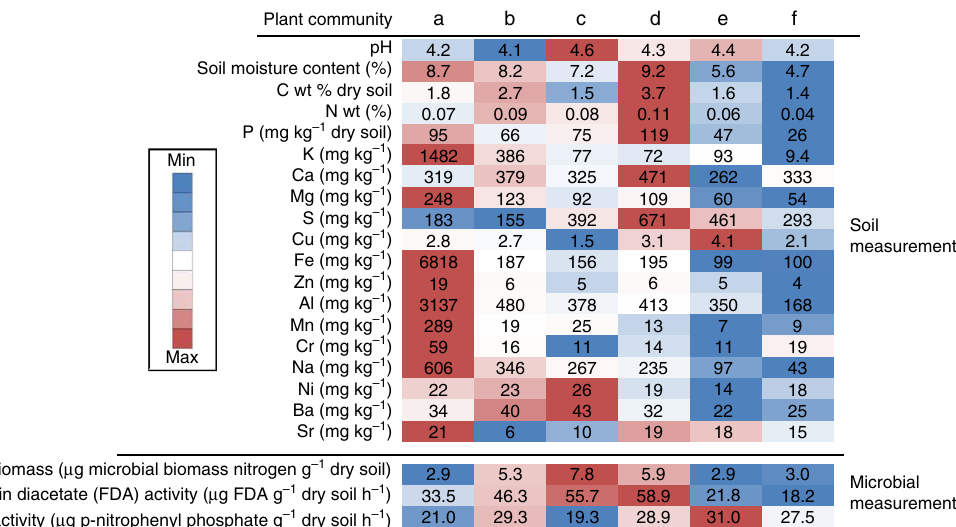
Fig. 3 Soil chemical characteristics, microbial biomass, total enzyme, and phosphatase activity measured in bulk soils. Values shown are the average of fi ve soil samples from each plant community sampling site, each sample a pool of three to ten individual soils (see Supplementary Table 2 for standard error of the mean and statistical analyses). Color shading represents concentration, biomass, or enzyme activity, and is based on standardized z- scores. Values above the respective means are colored red , values below the mean are colored